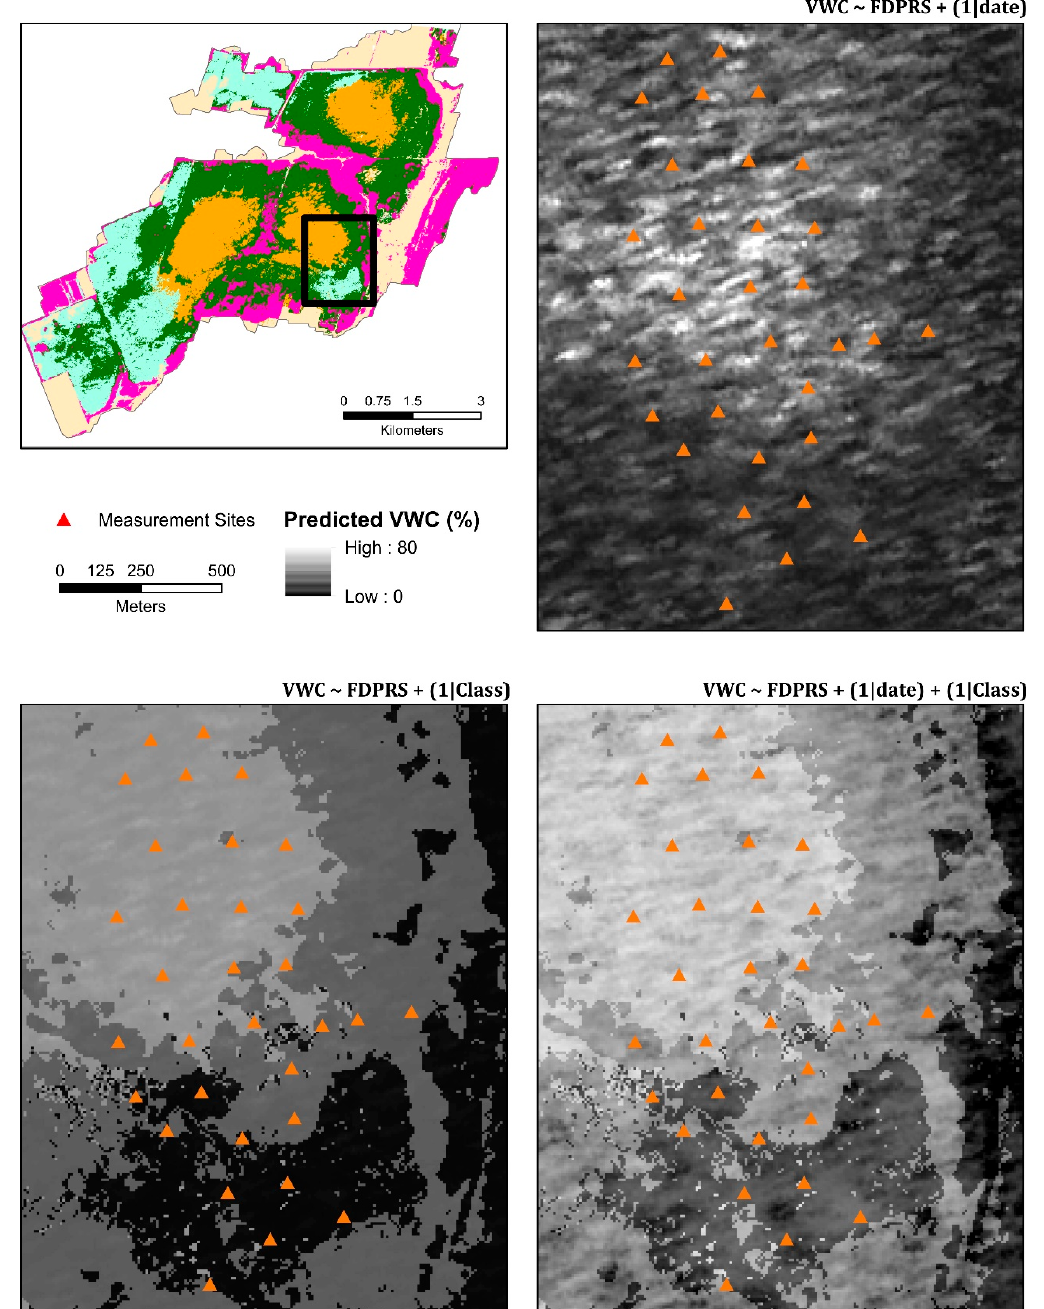
Figure 4. Examples of predicted volumetric water content (VWC) for 30 August 2014 based on three different Mixed Effects models. The Legend for the overview map follows Figure 2. We chose to display the results of the 30 August as, in single-date models published in previous research [20], this date resulted in the highest model explained variance (R 2 = 0.47) but the lowest independently validated explained variance (R 2 = 0.1) but was the highest independently validated single-date model in [20].